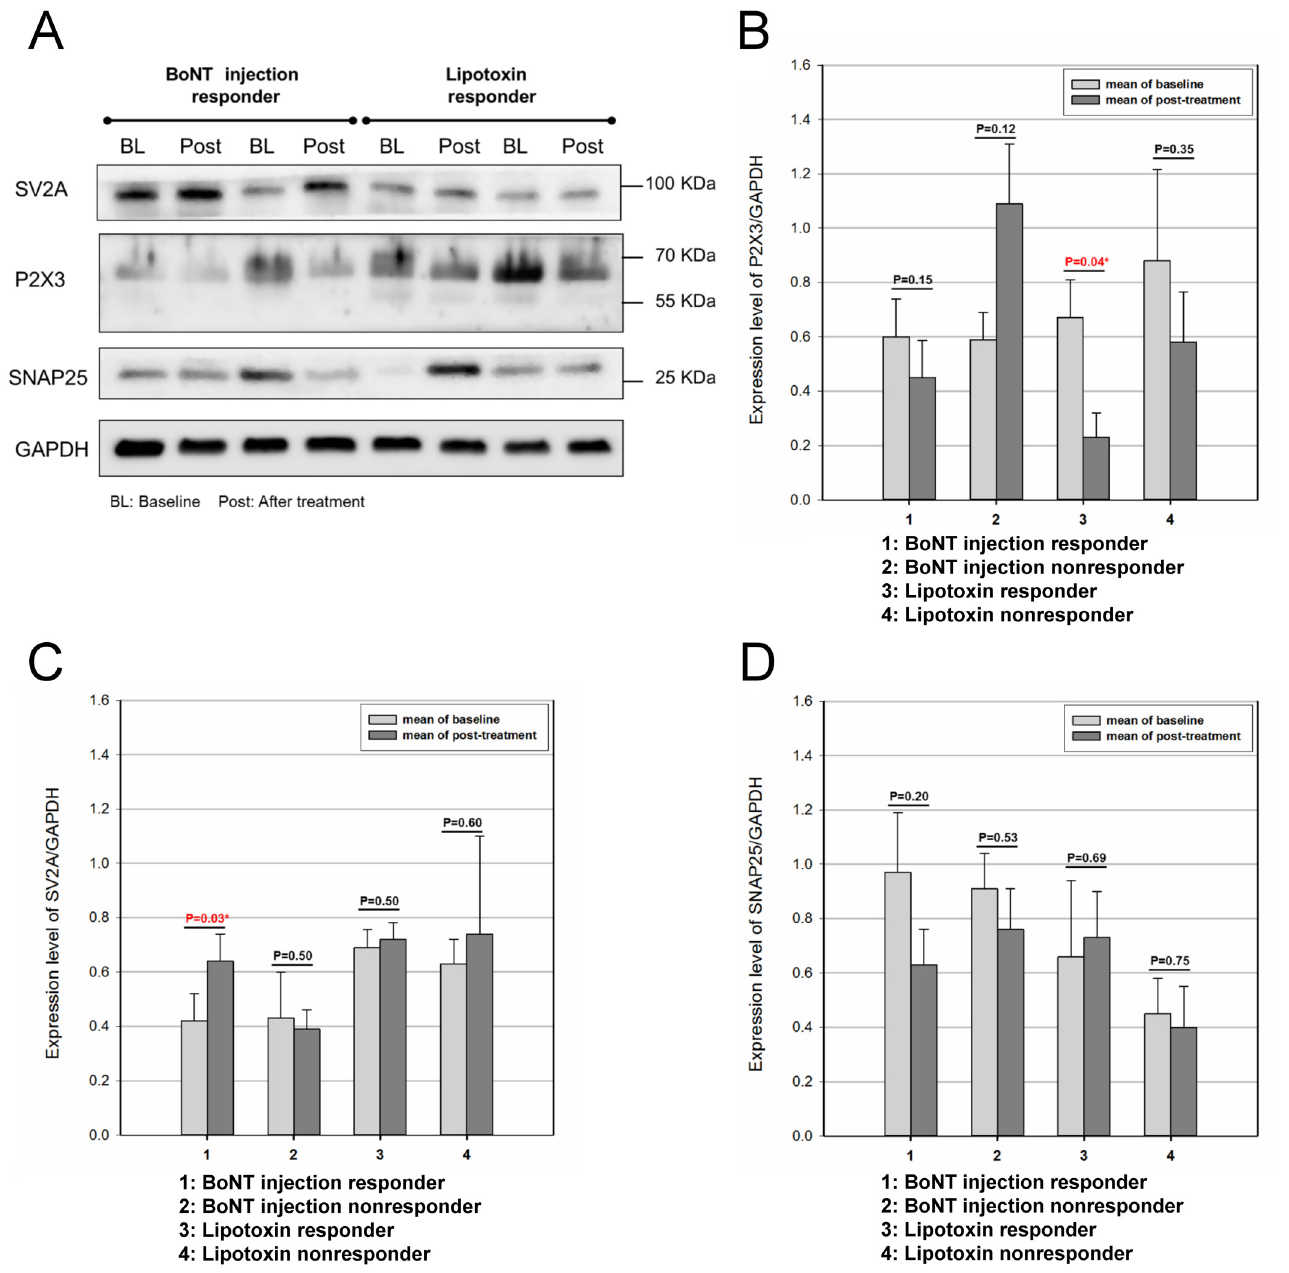
Fig 1. Expression of SV2A, P2X3 receptors, and SNAP-25 in the bladder mucosa of OAB patients at baseline and one month after BoNT-A injection or Lipotoxin treatment. (A) Immunoblot analysis of SV2A (95 KDa), P2X3 (66 KDa), and SNAP-25 (26 KDa) expression in OAB patients in response to BoNT-A injection or Lipotoxin treatment. (B, C, and D) Relative expression changes of P2X3, SV2A receptors, and SNAP-25, respectively, in OAB patients after BoNT-A injection or Lipotoxin treatment. There were no significant differences in any of the proteins between the BoNT-A responders and non- responders, or between the Lipotoxin responders and non-responders. GAPDH = glyceraldehyde phosphate dehydrogenase.